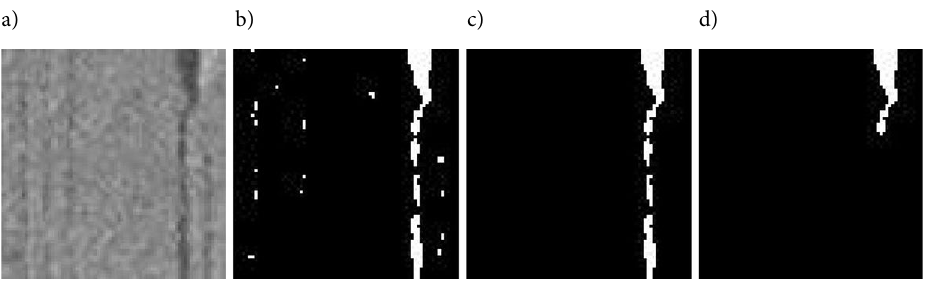
Figure 6. Example of noncontinuous pavement crack: a – raw crack block; b – local filtering; c – minor removal; d – maximum extraction